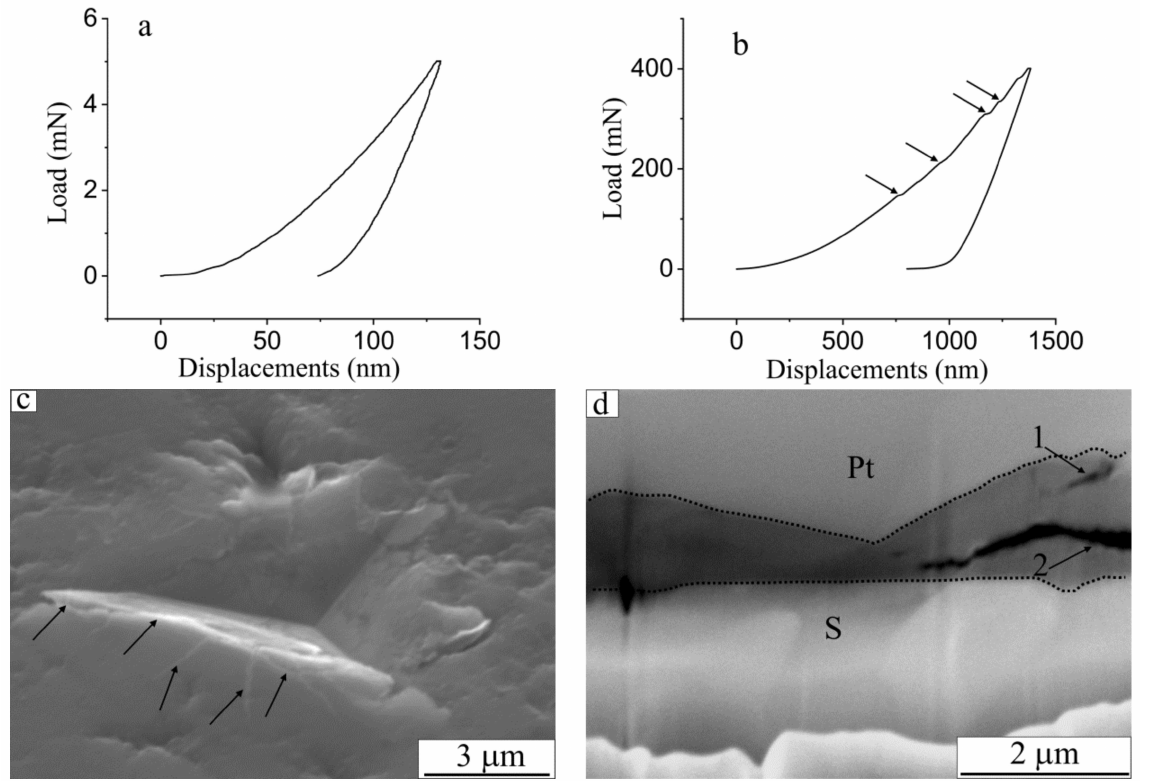
Figure 6. Load–displacement curves for indentation with different depths of maximum indenter penetration ( a , b ) and images (scanning microscopy) of indents in the coating plane ( c ) and coating cross-section ( d ). Notations in ( d ): S—substrate (T15K6 alloy), 1—inclined cracks on the indent’s ridges, 2—cracks throughout the interface between the